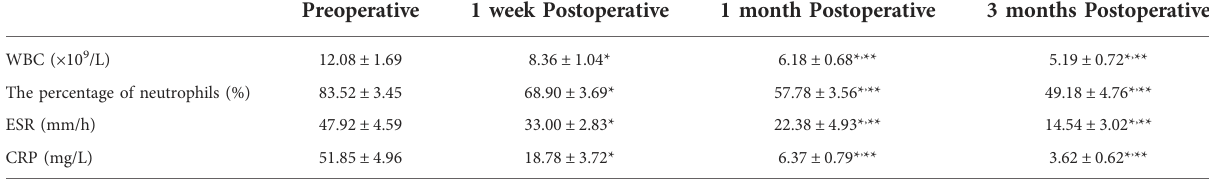
TABLE 3 Erythrocyte sedimentation rate (ESR), C-reactive protein (CRP), and white blood cell (WBC) count before and after surgery ( x ± s , n =13).